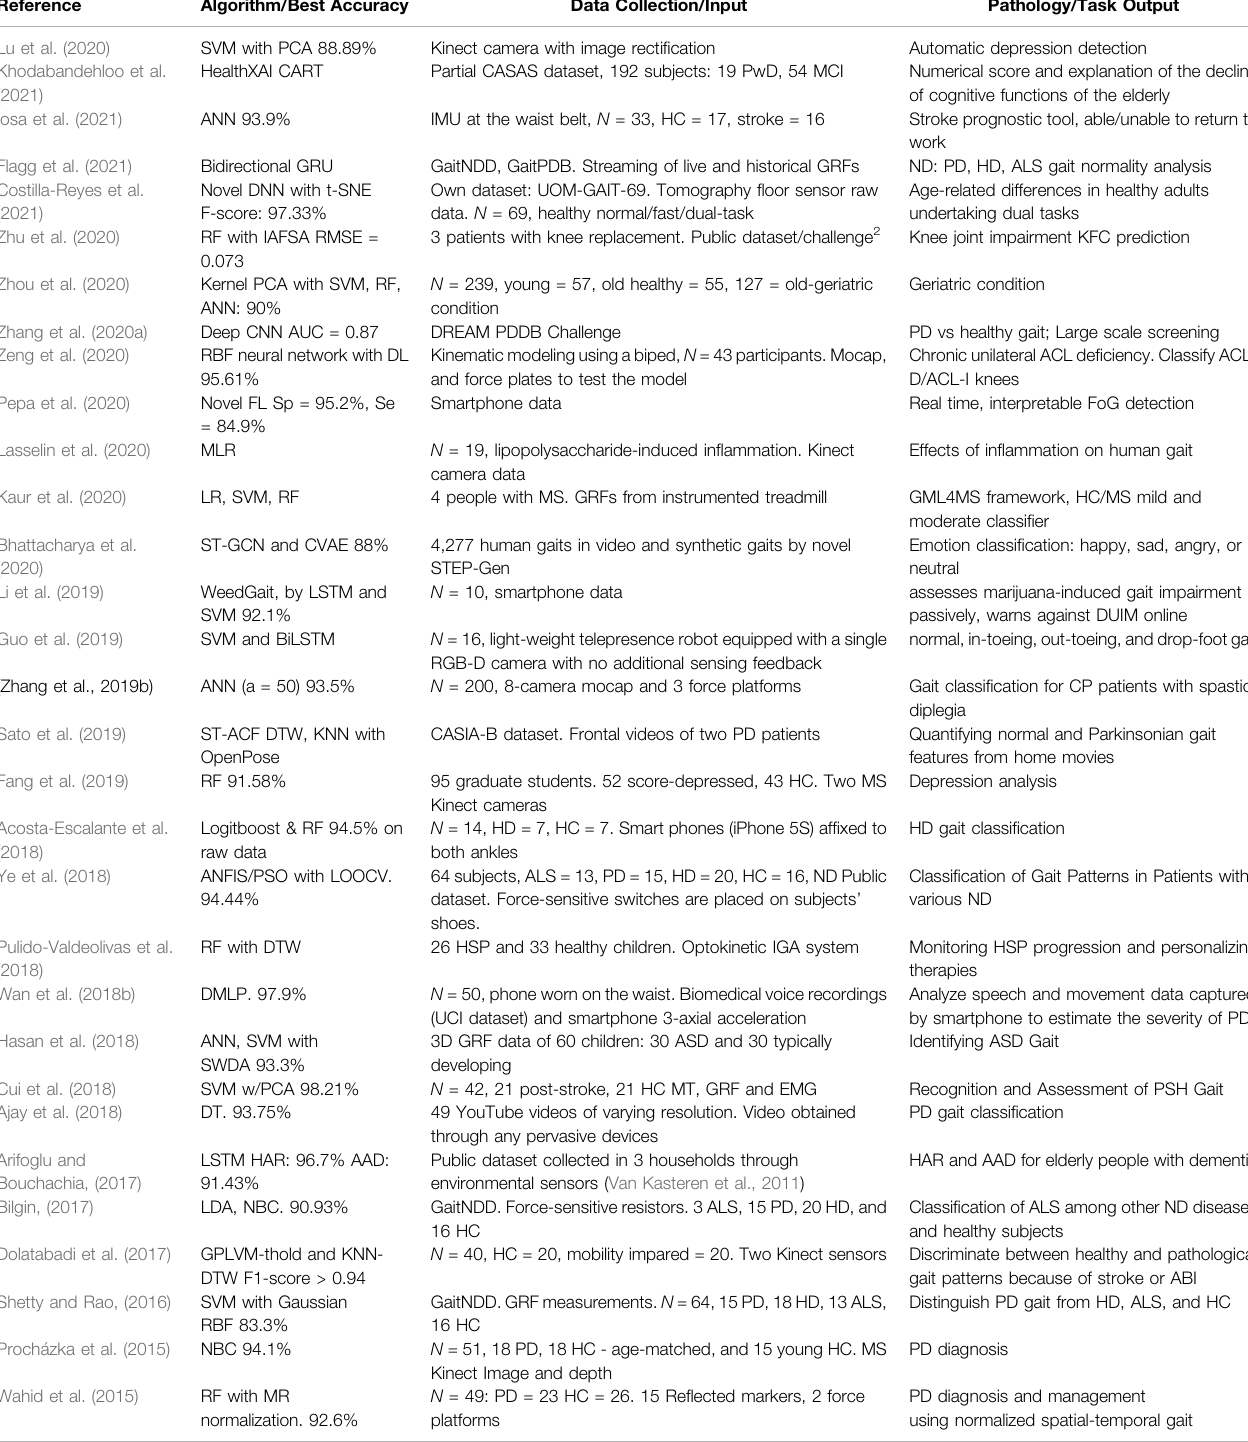
TABLE 4 | The pathological